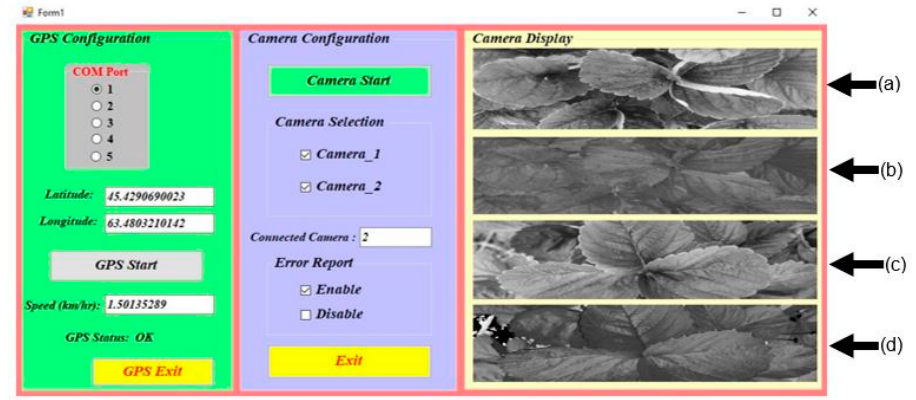
Figure 8. Machine vision-based powdery mildew disease detection software interface: a : g-ratio image from camera 1, b : hue image from camera 1, c : g-ratio image from camera 2, and d : hue image from camera 2.